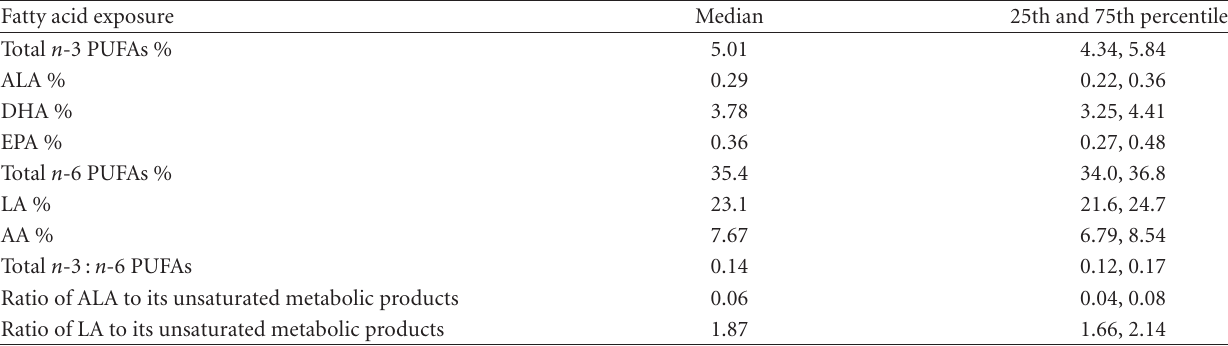
Table 3: Fatty acid composition of maternal plasma PC measured at 34 weeks’